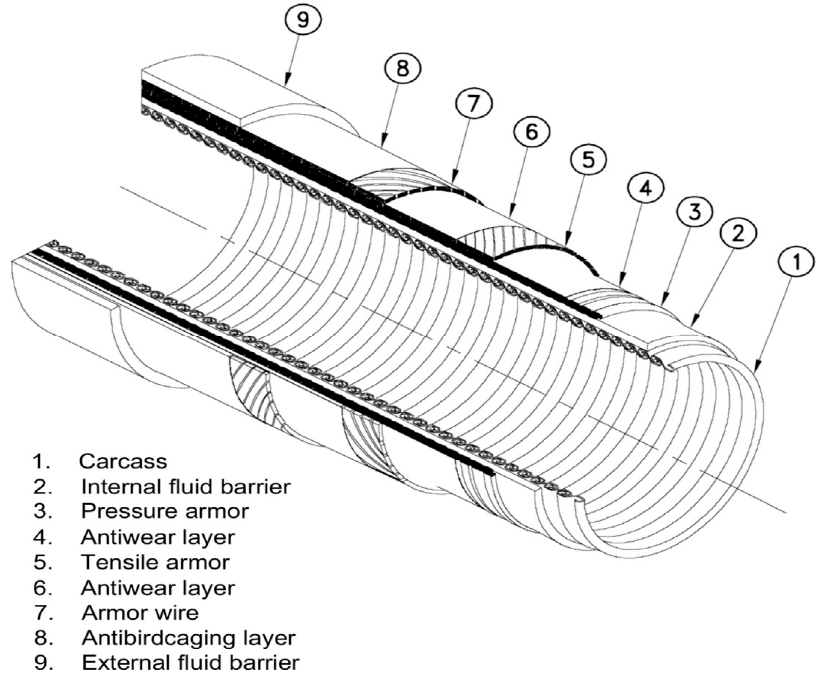
Figure 3. Flexible pipe [64].